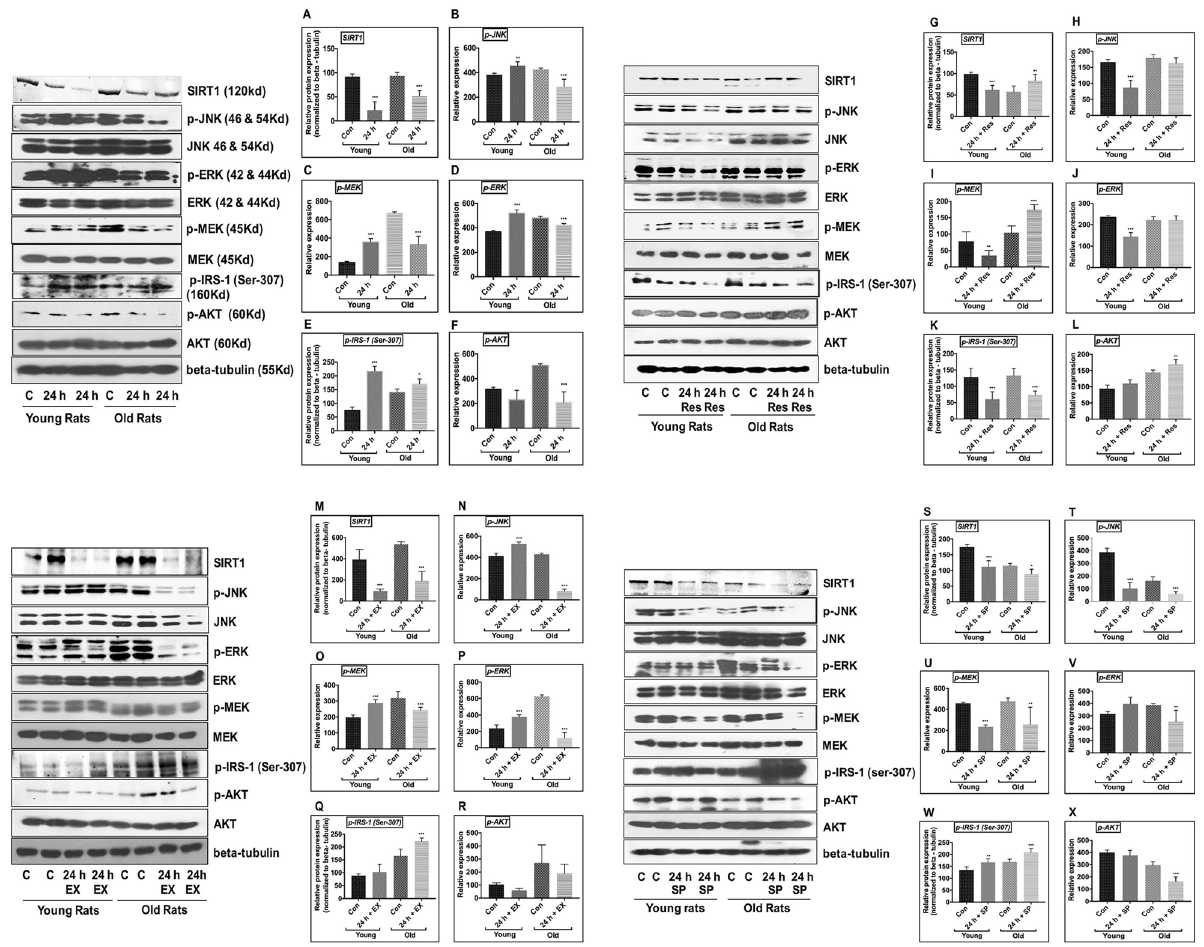
Figure 1. Effect of ischemia on the expression of SIRT1, JNK/ERK/MAPK/AKT signaling pathway in brains of control, 24 h MCAO, MCAO + EX-527, MCAO + resveratrol, and MCAO + SP600125 treatment in young and aged rat. Respective total proteins and beta-tubulin were served as the loading control (p-JNK, p-MEK, p-ERK, and p-AKT), while SIRT1 and p-IRS-1 were normalized to beta-tubulin. (A–F) Statistical results on the changes in expression of SIRT1, p-JNK, p-MEK, p-ERK, p-IRS-1, and p-AKT expression following CI. (G–L) Statistical results on the expression of SIRT1, p-JNK, p-MEK, p-ERK, p-IRS-1, and p-AKT on resveratrol treatment. (M–R) statistical results on the expression of SIRT1, p-JNK, p-MEK, p-ERK, p-IRS-1, and p-AKT on SIRT1 inhibition with EX-527. (S–X) Statistical results on the expression of SIRT1, p-JNK, p-MEK, p-ERK, p-IRS-1, and p-AKT on JNK inhibition with SP600125 treatment. The densitometry values are represented as mean ± SD (n = 5). *p < 0.05 versus sham